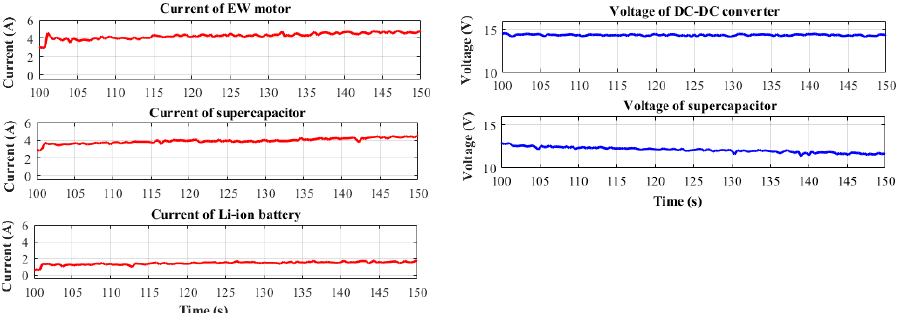
Figure 13. Experimental results for track-ABCD (points C–D).